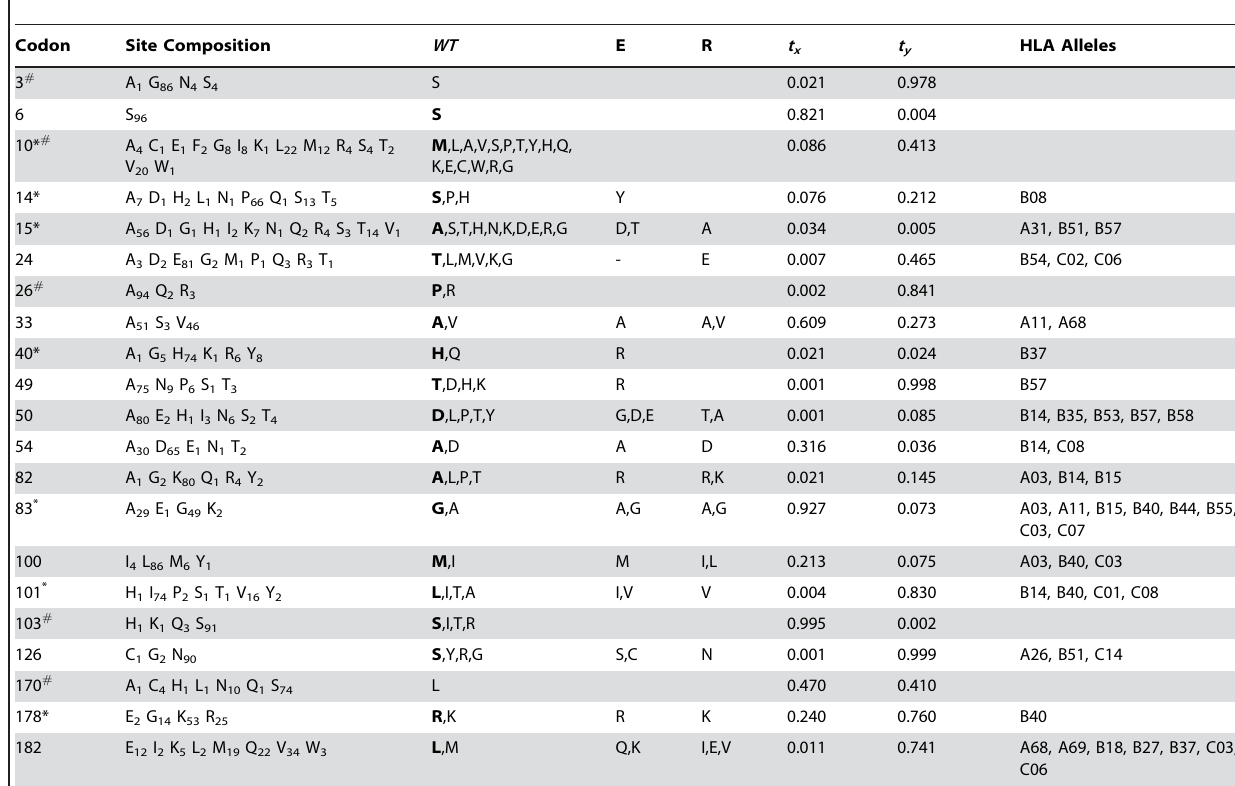
Table 4. HLA allele associated polymorphisms [4] at detected toggling sites.